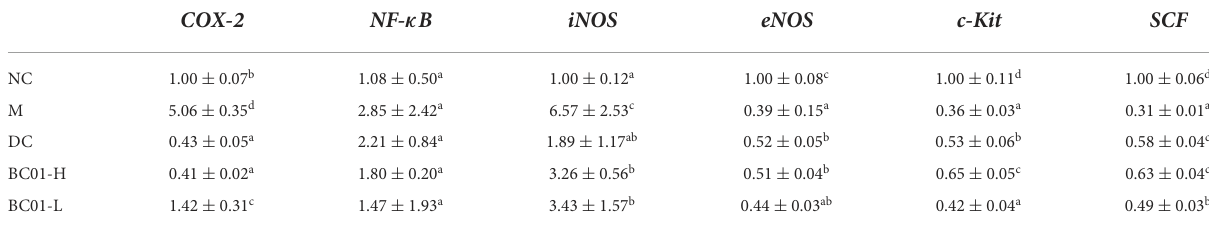
TABLE 2 The levels of mRNA